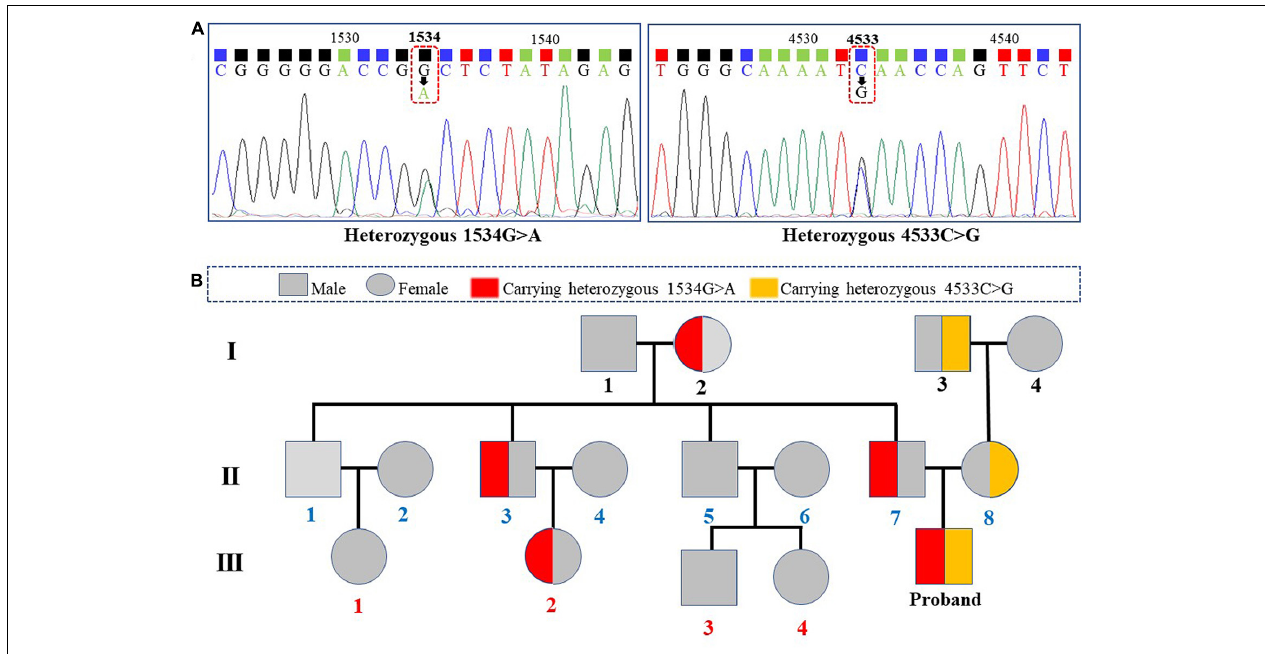
FIGURE 1 | Identification of compound heterozygous SCN10A mutations in our patient and inheritance of these mutations in his family. (A) Identified heterozygous SCN10A mutations in the patient. (B) Genetic linkage map for the patient and his family members in three